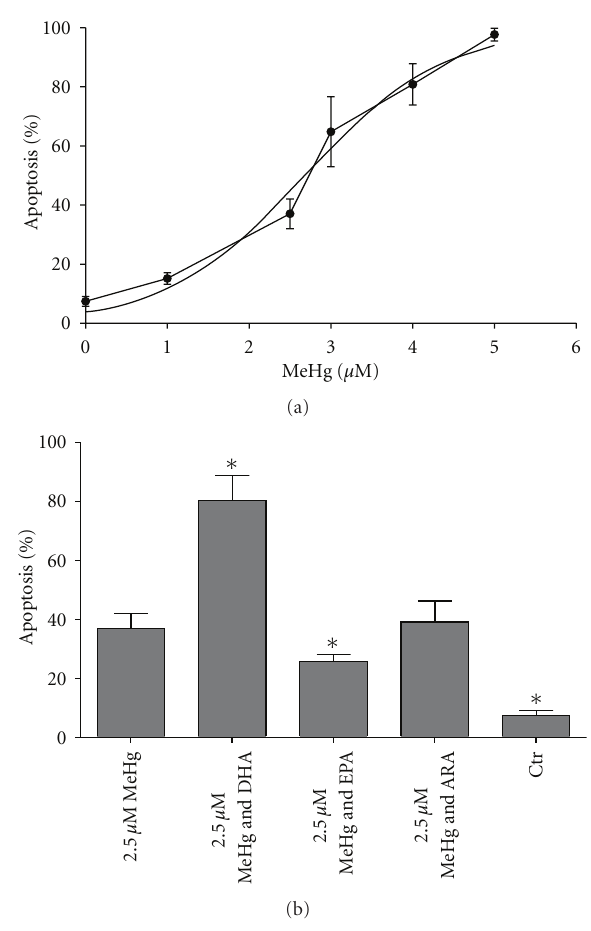
Figure 4: Apoptosis count of ASK cells after treatment with FA and MeHg. (a) MeHg dose-response with curve following a logarithmic nonlinear curve disposition ( r 2 = 0 . 9564); from this curve a con- centration which gave 40% apoptosis (approx. 2.5 μ M MeHg) was used in assay including fatty acids. (b) Apoptosis count after prein- cubation of cells with fatty acids. Results are presented as mean ± SD. Statistical di ff erences are revealed by one-way ANOVA and post hoc Dunnett’s test where n = 4. Significant di ff erences compared to 2.5 μ MMeHg ( P ≤ 0 . 05) are indicated by